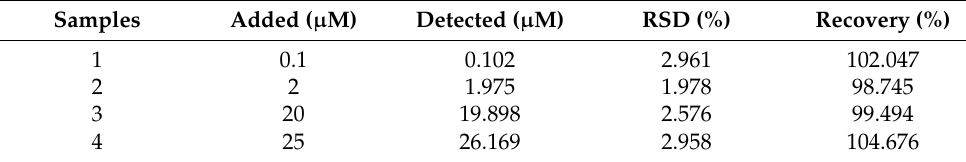
Figure 6. Verification of the specificity of the sensor. ATP and its analogues were fixed at 1 mM. Table 1. ATP detection in human serum